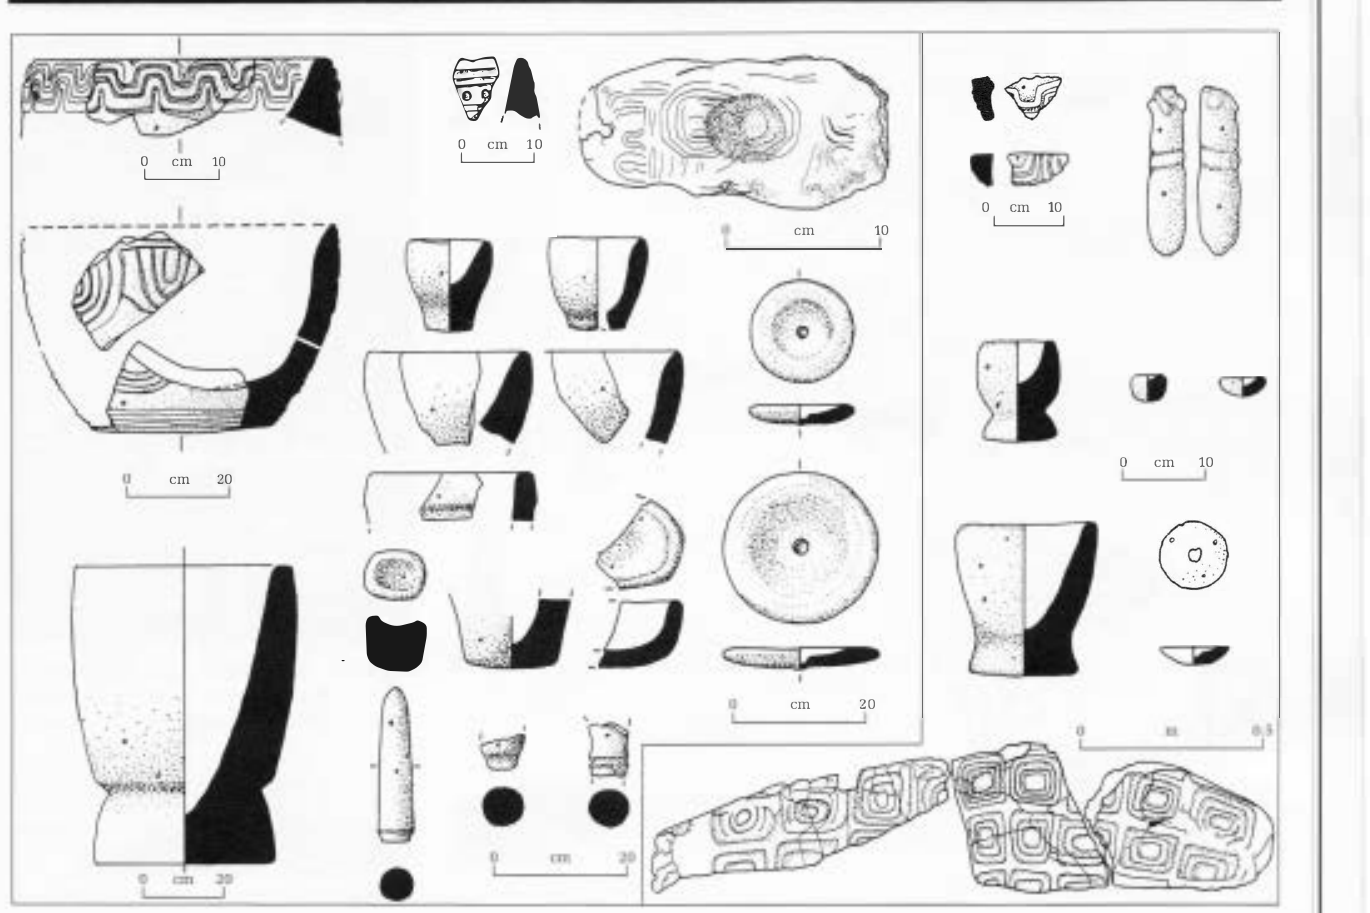
Figure 3 Natufian groundstone artefacts. Bowls, mortars, shallow discs and pestles from (left side) 'Ain Mallaha, Israel; (right side) Wa di Hammeh 27, Jordan (including the decorated wall slabs bottom right). Note the care taken to decorate some of the bowls and mo rtars, a suggestion of social ritual associated with these artefacts. For further information on sources seep. 93 in Wright 2000 (n. 1). in Natufian sites, are considerably more frequent in PPNA sites.21